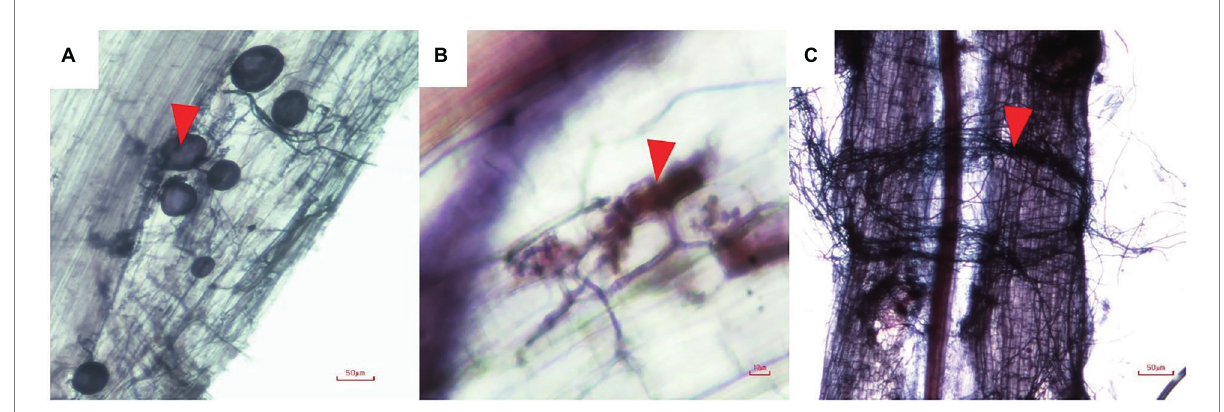
FIGURE 1 Morphology of AMF in root of Cannabis sativa (A) , vesicles (arrow head); (B) , Arum-type arbuscules (arrow head), and (C) hyphae around plant roots (arrow